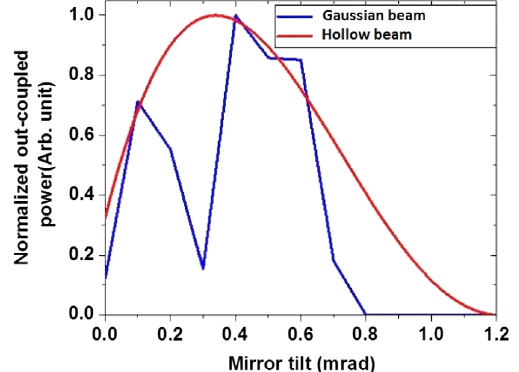
m.FIG. 9. Out-coupled power as a function of mirror tilt with Gaussian and hollow electron beams at λ ¼ 10 μ m, for a confocal